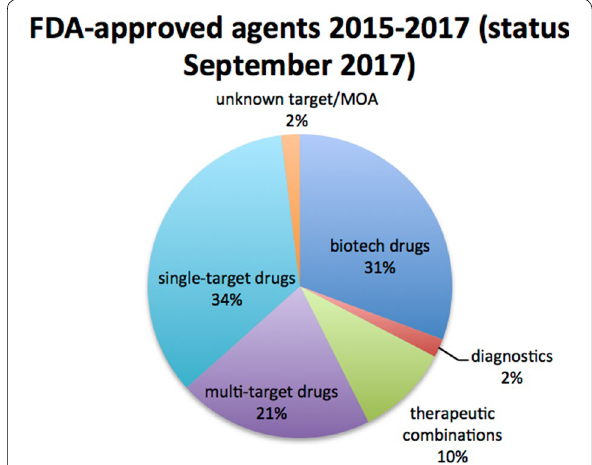
Fig. 1 Distribution of the new molecular entities (NMEs) approved from 2015 to 2017 (status September 2017), organized according to the different classes of